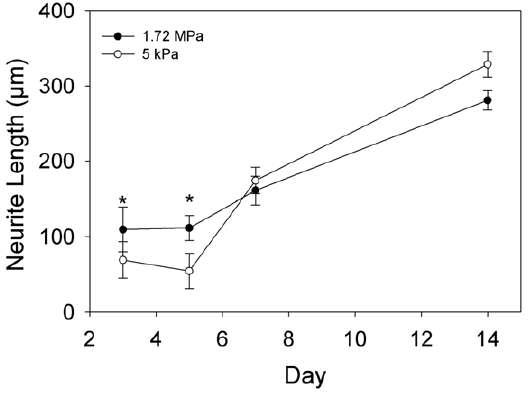
Figure 7. Quantification of neurite length for PC12 cells N cultured on two different PDMS formulations. PC12 cells were , black circles) and 5 kPa ( # , white circles) cultured on 1.72 MPa ( PDMS and evaluated at days 3, 5, 7 and 14. At days 3 and 5, neurite length on 1.72 MPa PDMS was significantly greater compared to neurite length on 5 kPa PDMS. On days 7 and 14 the neurite length was equivalent on both PDMS types. This suggests that PC12 neurites initially grow faster on stiffer PDMS substrates (up to 5 days), but by 7 days the growth rate has slowed on the stiffer PDMS and accelerated on the softer PDMS such that neurite lengths are equivalent. Data represented as mean 6 standard error of the mean. Statistical significance at each time point determined by a Mann-Whitney Rank Sum Test, *indicates p # 0.001.